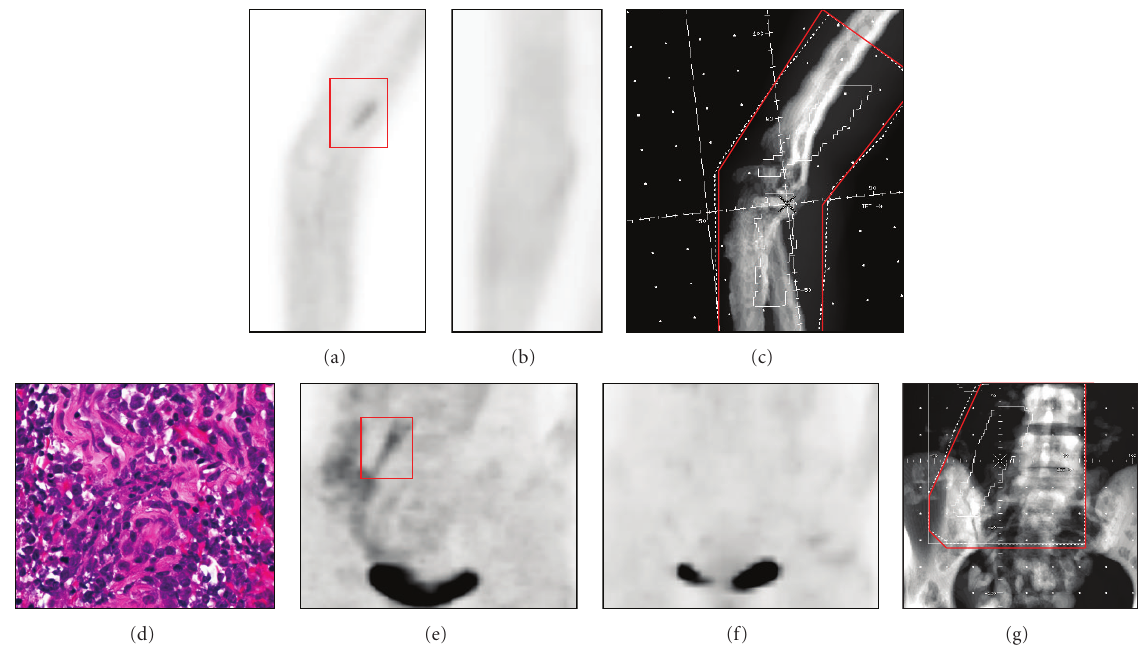
Figure 1: Recurrent neurotropic chloroma of the right ulnar nerve on (a) pretreatment Positron Emission Tomography (PET) outlined in red demonstrating resolution (b) of hypermetabolic activity after treatment to 24 Gy to (c) the field outlined in red. Biopsy proven recurrent neurotropic chloroma on high power view with Heamtoxylin-Eosin staining (d) along the right psoas muscle outlined in red on (e) pretreatment PET demonstrating resolution (f) of hypermetabolic activity after treatment to 24Gy to (g) the field outlined in red.